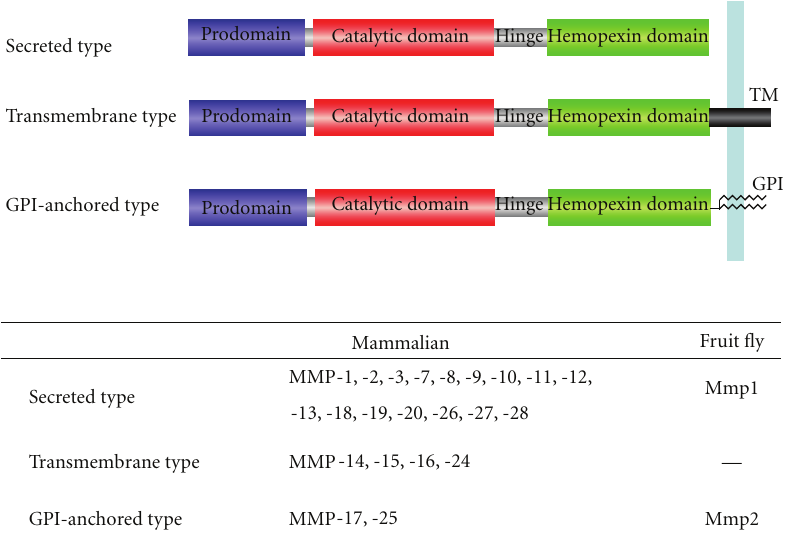
Figure 1: Domain structures of typical MMP family members in mammal and fruit fly. Hinge, hinge region; PM, plasma membrane; TM, transmembrane domain; GPI, glycosyl-phosphatidylinositol linker. The signal sequence located at the amino terminus of all prodomain is not